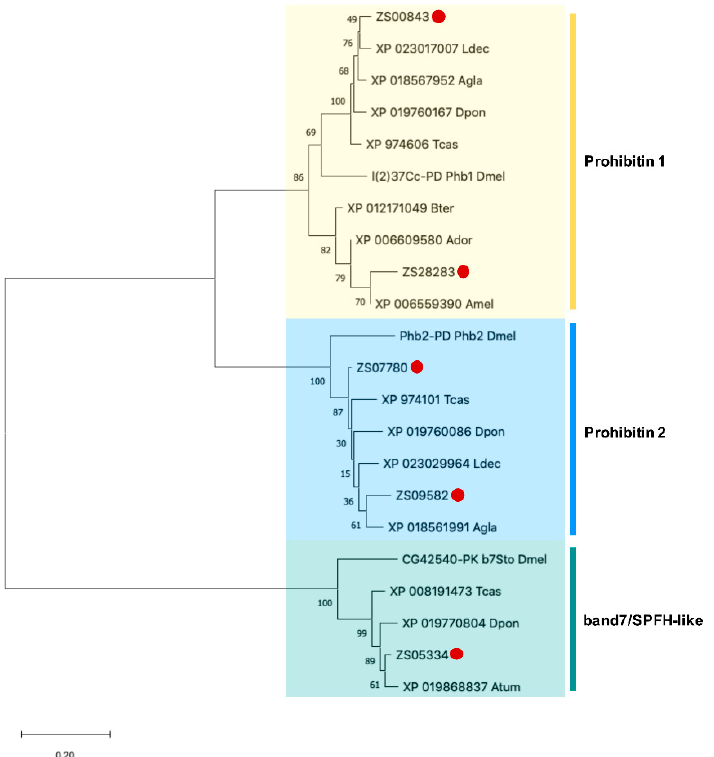
Figure 7. Phylogenetic analysis of putative prohibitin proteins of Z. subfasciatus and other species. The phylogenetic tree was generated by MEGA X using the neighbor-joining method with 1000 bootstrap replicates. The accession number or symbol gene is shown. Amino acid sequences from other species used for comparison: Atum ( Aethina tumida ), Agla ( Anoplophora glabripennis ), Ador ( Apis dorsata ), Amel ( Apis mellifera ), Bter ( Bombus terrestris ), Dpon ( Dendroctonus ponderosae ), Ldec ( Leptinotarsa decemlineata ), Tcas ( Tribolium castaneum ), Dmel ( Drosophila melanogaster ). The proteins were clustered into prohibitin 1, prohibitin 2 and band7/SPFH-like groups. Colored boxes represent proteins belonging to the same group. Putative targets for PF2 lectin are identified by a red dot. The scale bar represents the branch lengths.